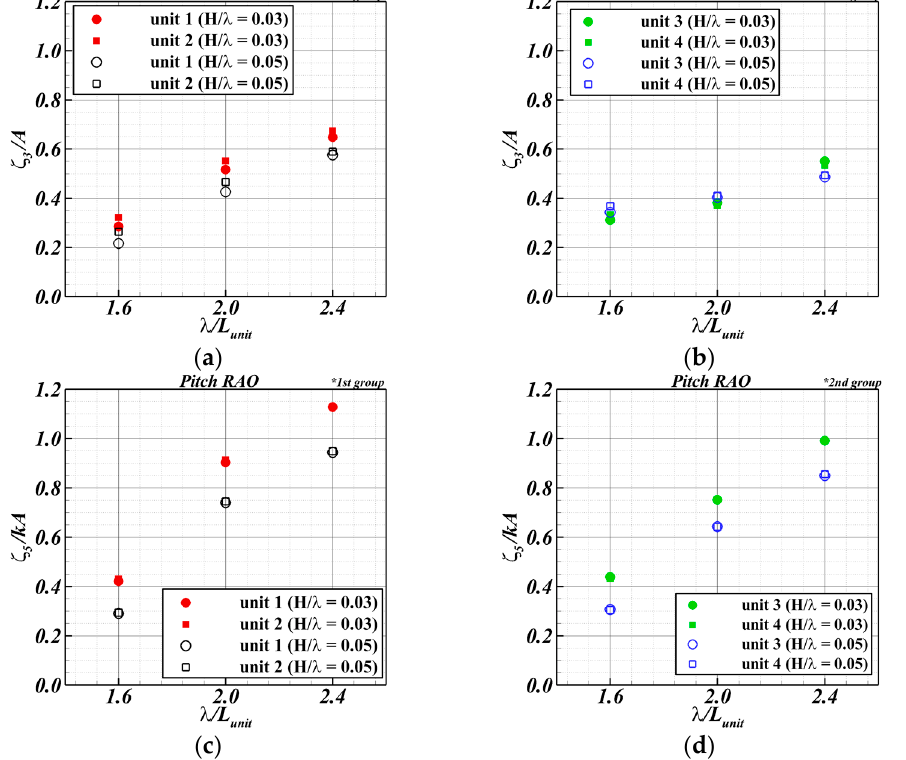
Figure 20. Motion RAOs of the experiment according to wave steepness: ( a ) heave (first group); ( b ) heave (second group); ( c ) pitch (first group); ( d ) pitch (second group).